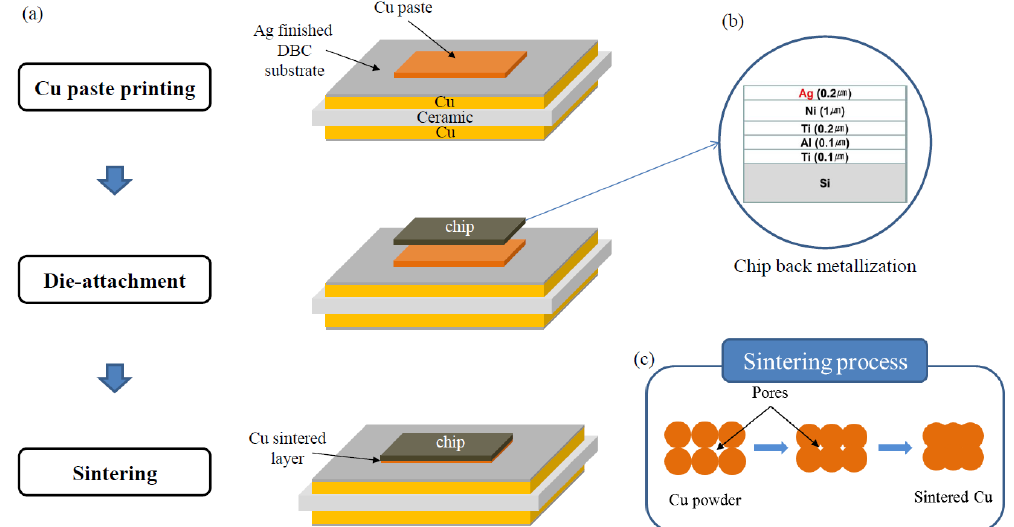
Figure 2. ( a ) Sample fabrication steps used in this study, ( b ) schematic of the chip back metallization and ( c ) schematic of the sintering process. and ( c ) schematic of the sintering